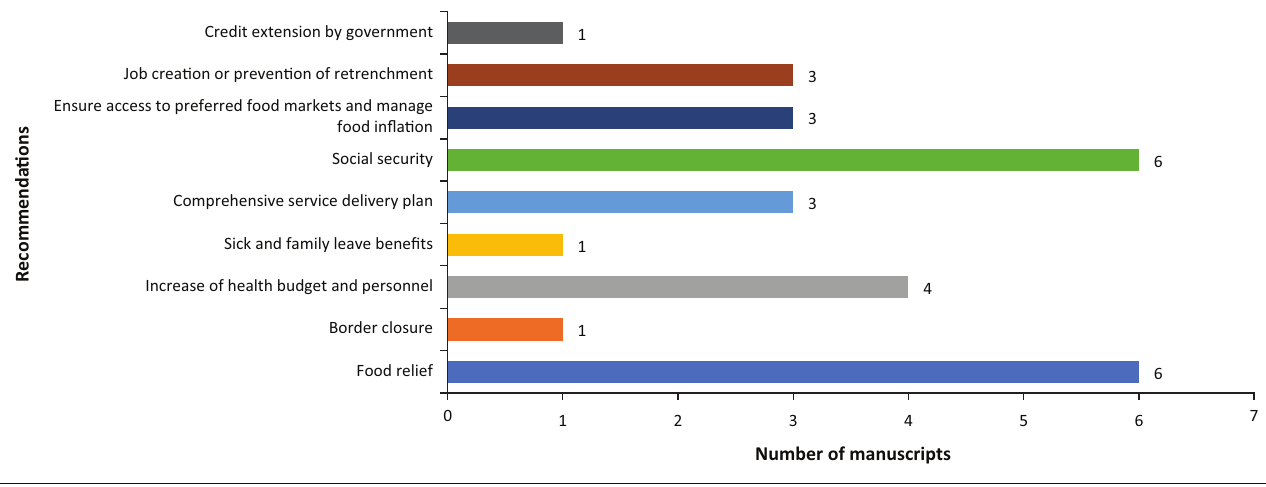
FIGURE 9: Recommendations for improving the response to